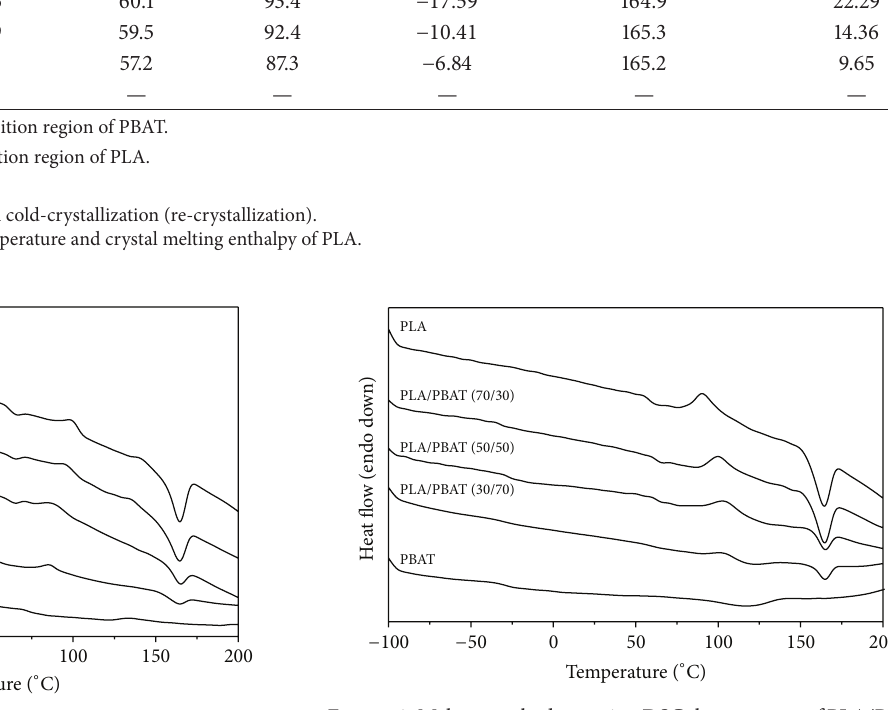
Figure 1: Initial scanning DSC thermogram of PLA/PBAT blends.